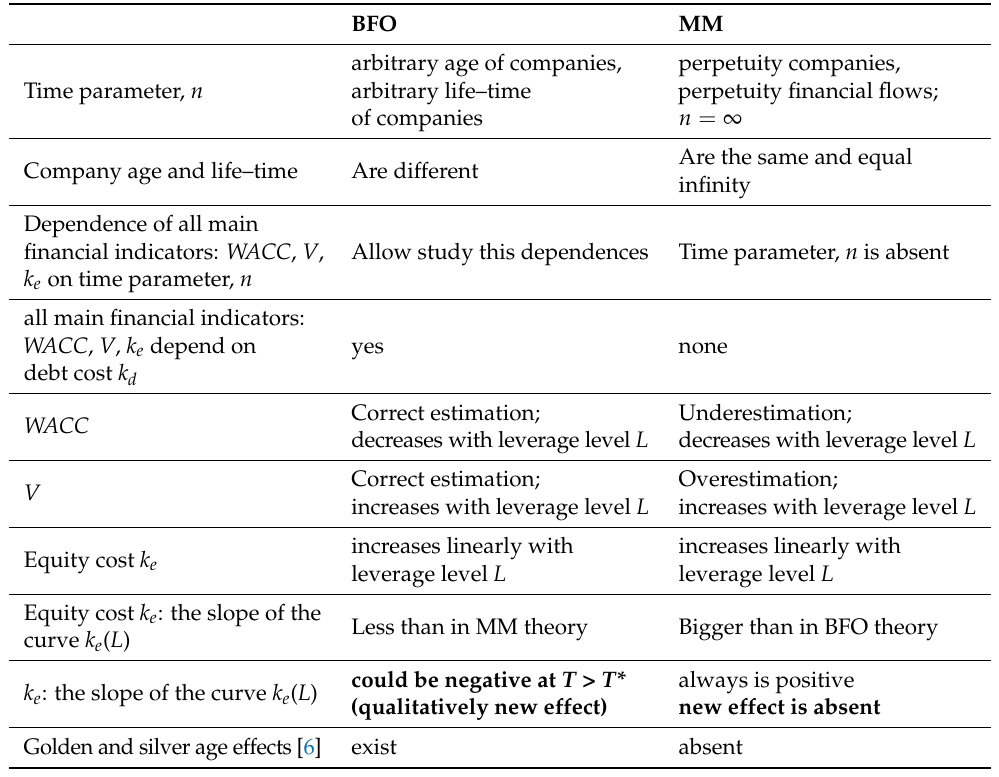
Table 1. The similarities and differences between BFO and MM